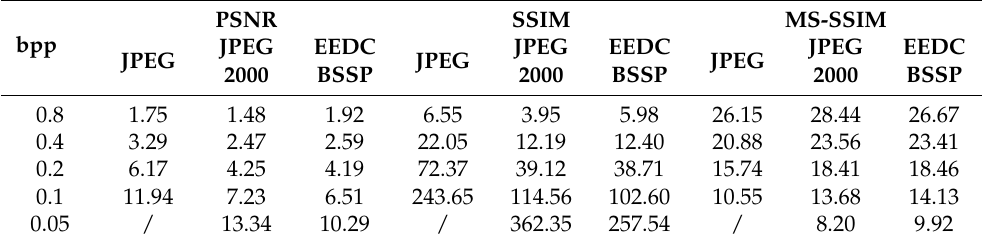
Table 18. Results of the AAE, MSE, and SNR metrics for image pills .